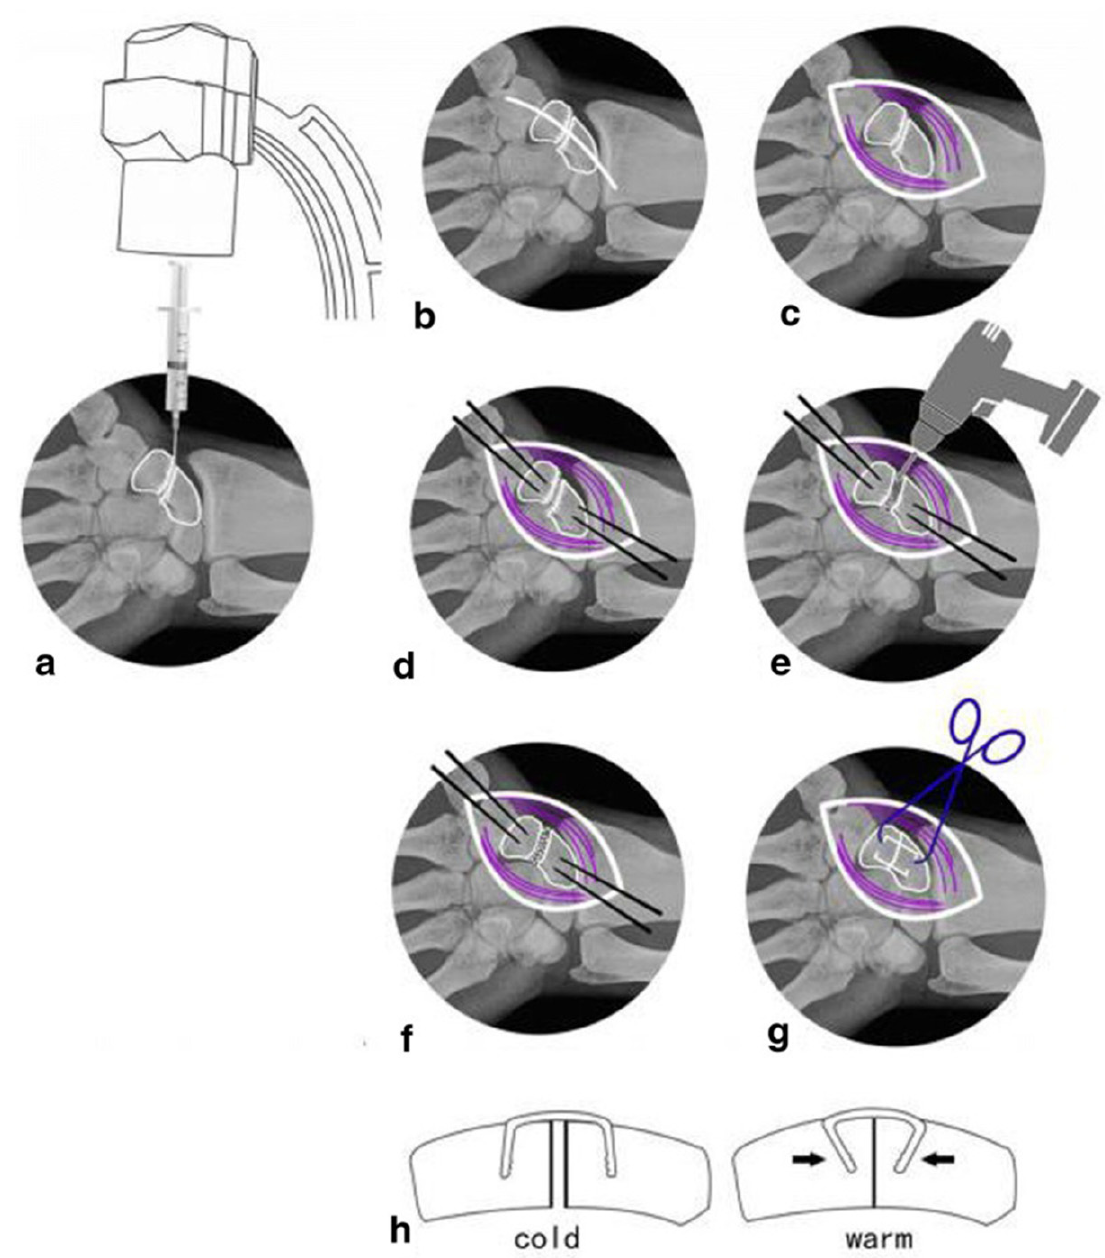
Figure 2. Nitinol dome memory alloy connector used to treat navicular nonunion. ( a – c ) Puncture the position with a 5ml syringe needle under the fluoroscopy of the c-arm, and expose the scaphoid nonunion. ( d ) Determine the appropriate implantation position at the proximal and distal ends of the bone. ( e ) Remove fibrous scar tissue and hardened calluses through electric drilling. ( f ) Repair the cancellous bone graft with attachment cortex. ( g , h ) Select a suitable NiTi alloy and insert it, then spray warm (35–40 ◦ C) salt water to gradually tighten the extended arm until it almost reaches its original shape. (Reproduced with permission [118]. Copyright 2019, Springer